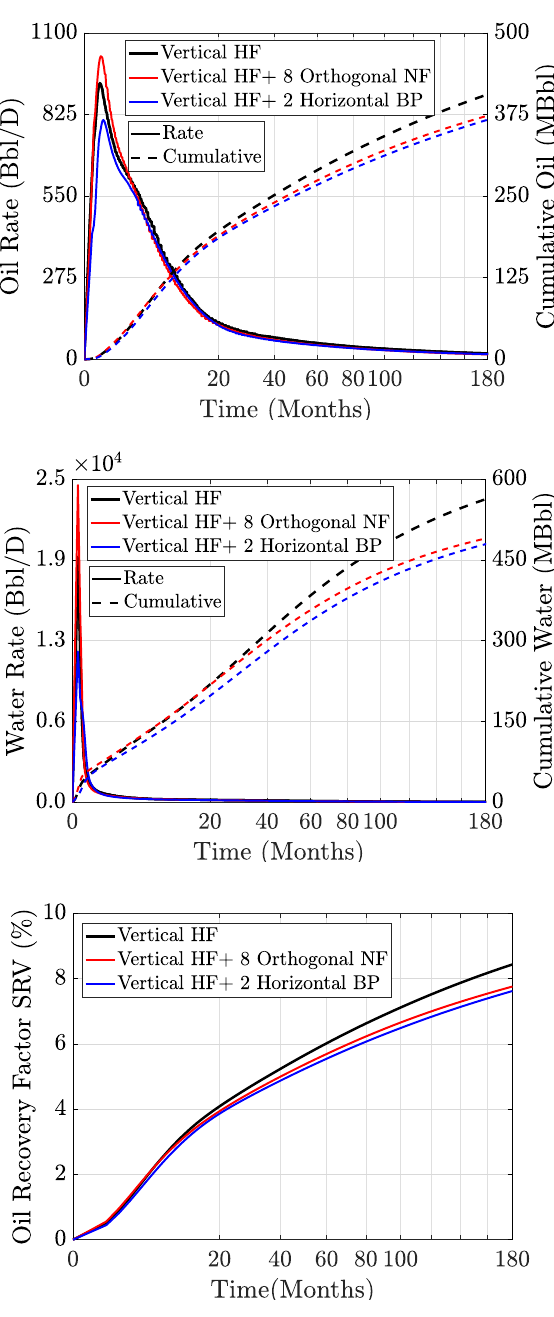
Figure 10. Simulation case 1: 15 years of reservoir fluid production obtained by varying hydraulic fracture geometry. Fracture scenario #1 is the reference case, which has only three vertical hydraulic fractures (HF) (black line). Fracture scenario #2 has three vertical hydraulic fractures and eight orthogonal natural fractures (NF) (red line). Fracture scenario #3 has three vertical hydraulic fractures and two horizontal bedding planes (BP) (blue line). All the fracture scenarios have a uniform vertical hydraulic fracture permeability of 2000